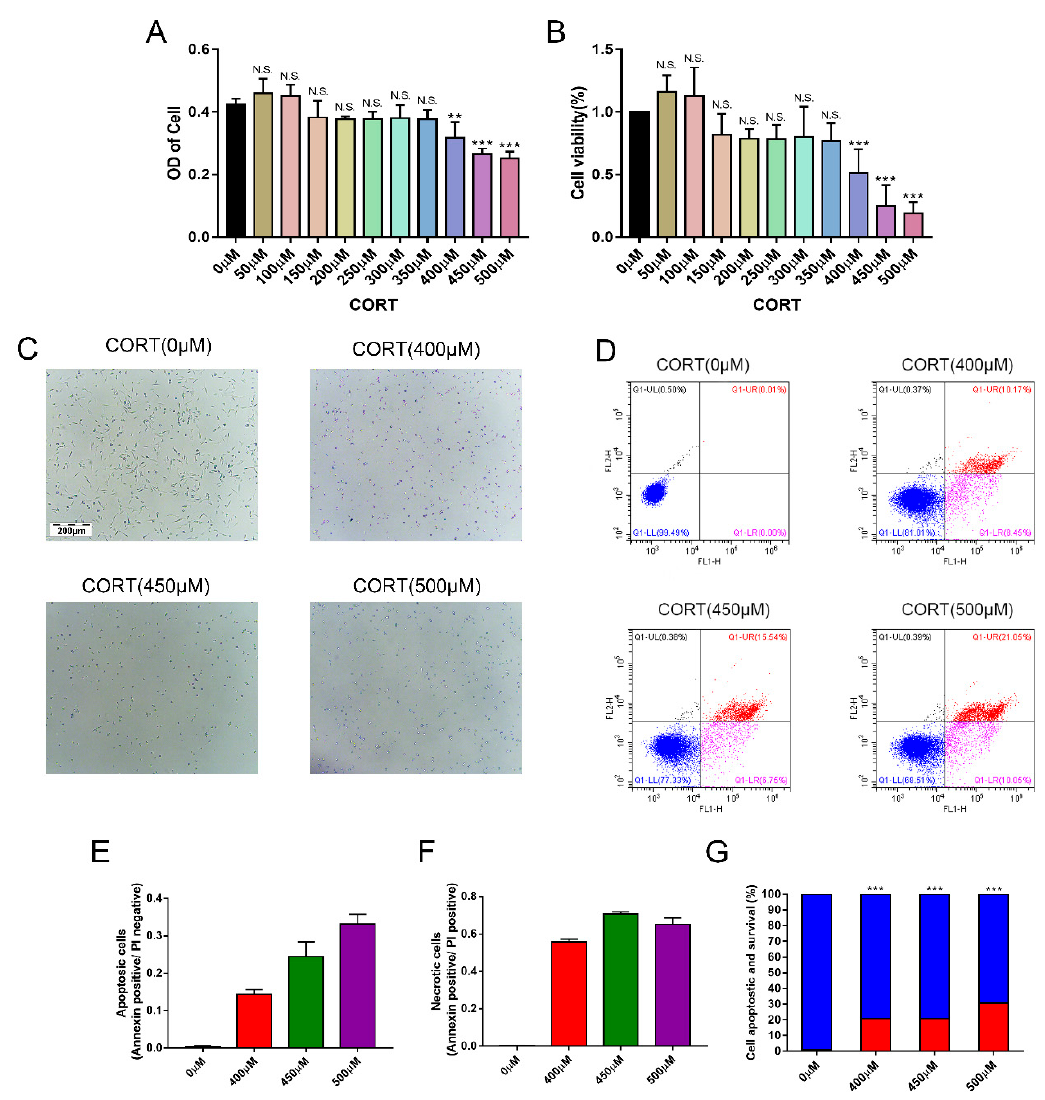
Figure 5. The effects of cortisol (CORT) on the cell viability of hippocampus neuronal HT22 cells. ( A , B ) HT22 cells were treated with different concentrations of CORT (400–500 μ M) for 3 h. Cell viability was measured using the CCK-8 assay. Data were between control (CORT 0 μ M) vs. CORT of different concentrations, and were analyzed by one-way analysis of variance. The results are expressed as the mean ± SD ( n = 3) in each independent experiment. NS: not significant; ** P < 0.01; *** P < 0.001. HT22 cells were treated with different concentrations of CORT (400–500 μ M) for 3 h. ( C ) Microscopic images of cells after treatments with different concentration of CORT. ( D ) HT22 cell apoptosis was detected by flow cytometry after labeling with FITC-Annexin V (FITC-A, X-axis) and propidium iodide (PI, Y-axis). ( E ) The apoptotic cell number (%) after CORT treatment and ( F ) the proportions of normal and dead cells after CORT treatments; normal cells are blue and dead cells are red. Data were between control (CORT 0 μ M) vs. CORT (400 μ M), CORT (450 μ M), and CORT (500 μ M), and were analyzed by one-way analysis of variance. Data (E, F) are expressed as the mean ± SD ( n = 3) in each independent experiment; *** P < 0.001.